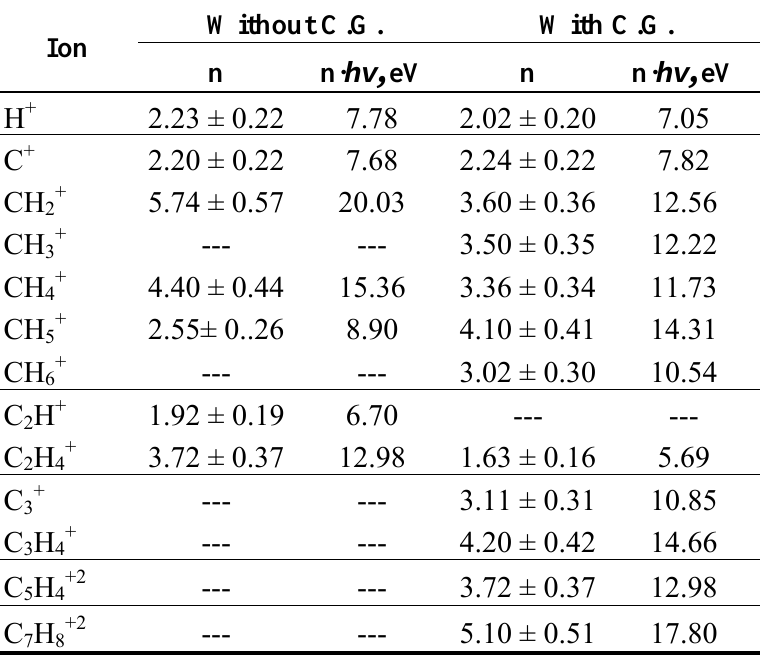
Table 1. Calculated relative ion yield of PD of